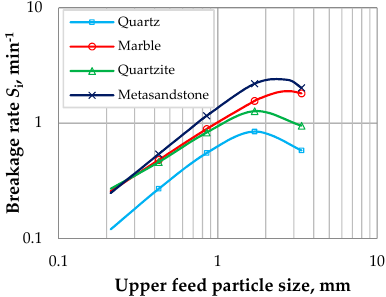
Figure 9. Variation of breakage rate S i vs. upper feed particle size. Table 5. Breakage rate parameters for all materials used.